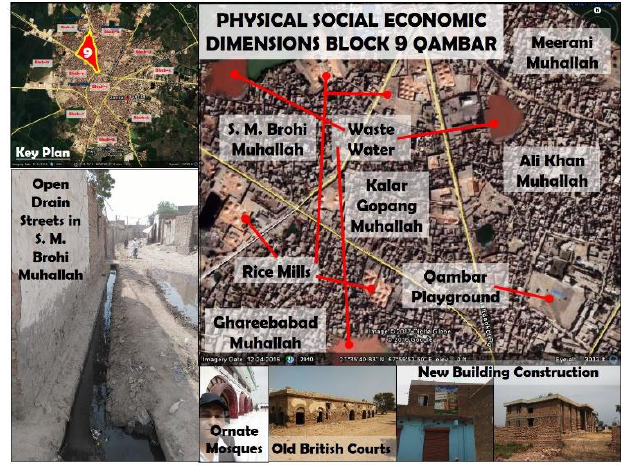
Fig. 13 . Analysis of urban design principles in Qambar: physical, social, and economic dimensions of city in block